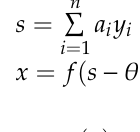
Figure 3. The signal transmission model of the neuron.